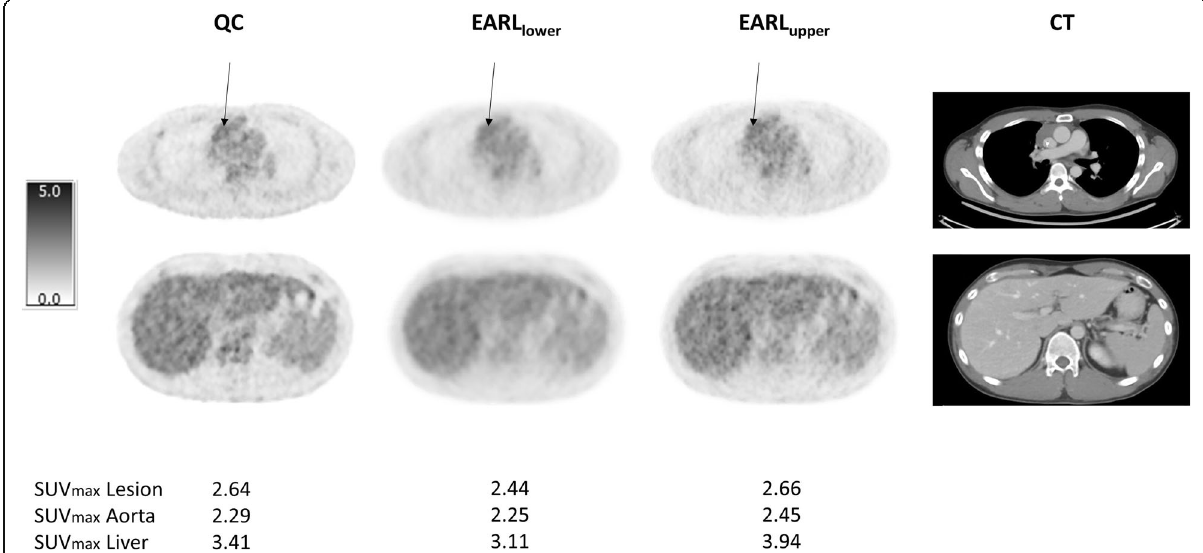
Fig. 2 Good concordance in DS. Representative example of patient who had good concordance between QC, EARL lower and EARL upper DSs. This patient was classified as DS 3 on all reconstruction settings. Transversal images in the thorax (aorta and lesion (indicated with an arrow) with highest SUV max ) — upper row — and in the abdomen (liver) — lower row — for the three different reconstructions including the corresponding CT are